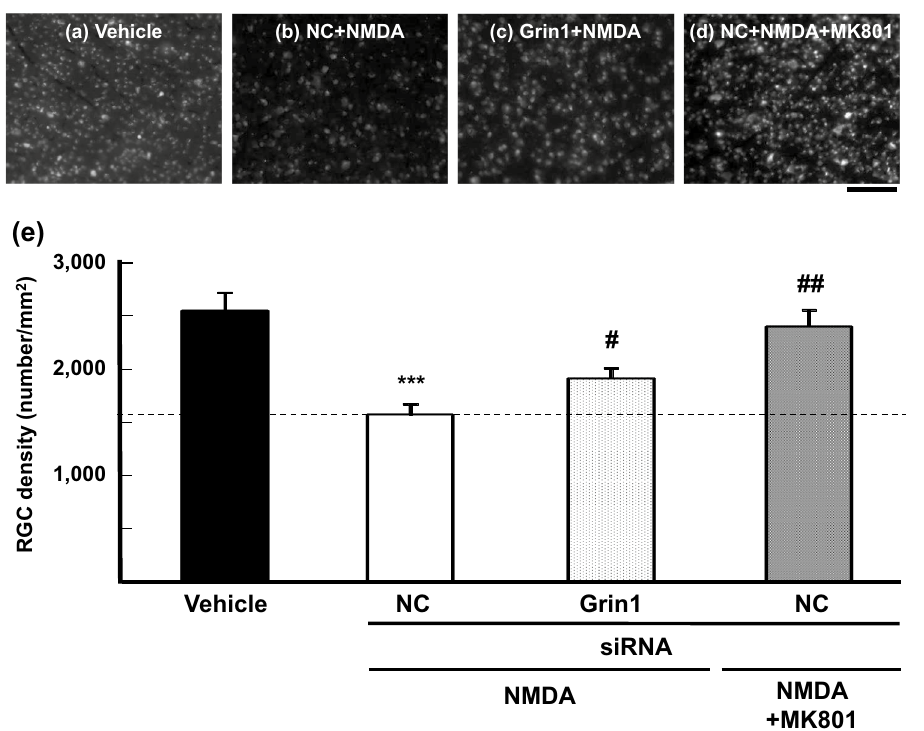
Figure 4. Inhibition of NMDA induced-retinal ganglion cell death following intravitreal injection of siRNA targeting Grin1. The photographs represent fluorogold-labeled RGCs in the flat-mounted rat retina treated with vehicle ( a ), negative control siRNA (NC) + NMDA ( b ), Grin1 siRNA + NMDA ( c ) and NC + NMDA + MK-801 ( d ) 7 days after intravitreal injection of NMDA. The scale bar represents 100 µm. The number of fluorogold- labeled RGCs was quantified on each image and is shown in ( e ). Vehicle, closed column; NC + NMDA, open column; Grin1 siRNA + NMDA, light gray column; NC + NMDA + MK-801, dark gray column. Each value represents the mean ± S.E.M. for n = 4–8. *** P < 0.001 versus vehicle (Student’s t -test), # P < 0.05, ## P < 0.01 versus NC siRNA with NMDA (Student’s t